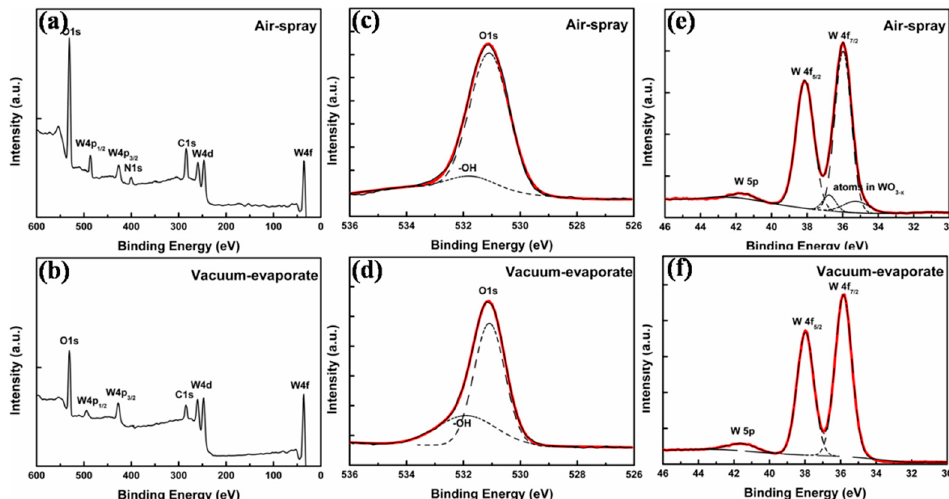
Figure 2. X-ray photoelectron spectroscopy (XPS) spectra of different process tungsten oxide (WO 3 ) films. ( a ) Full scan; ( c ) W (4f) core levels and ( e ) O (1s) core levels of spray-coated WO 3 (S-WO 3 ) film, respectively; ( b ) Full scan; ( d ) W (4f) core levels and ( f ) O (1s) core levels of evaporated WO 3 ) E-WO 3 film, respectively.